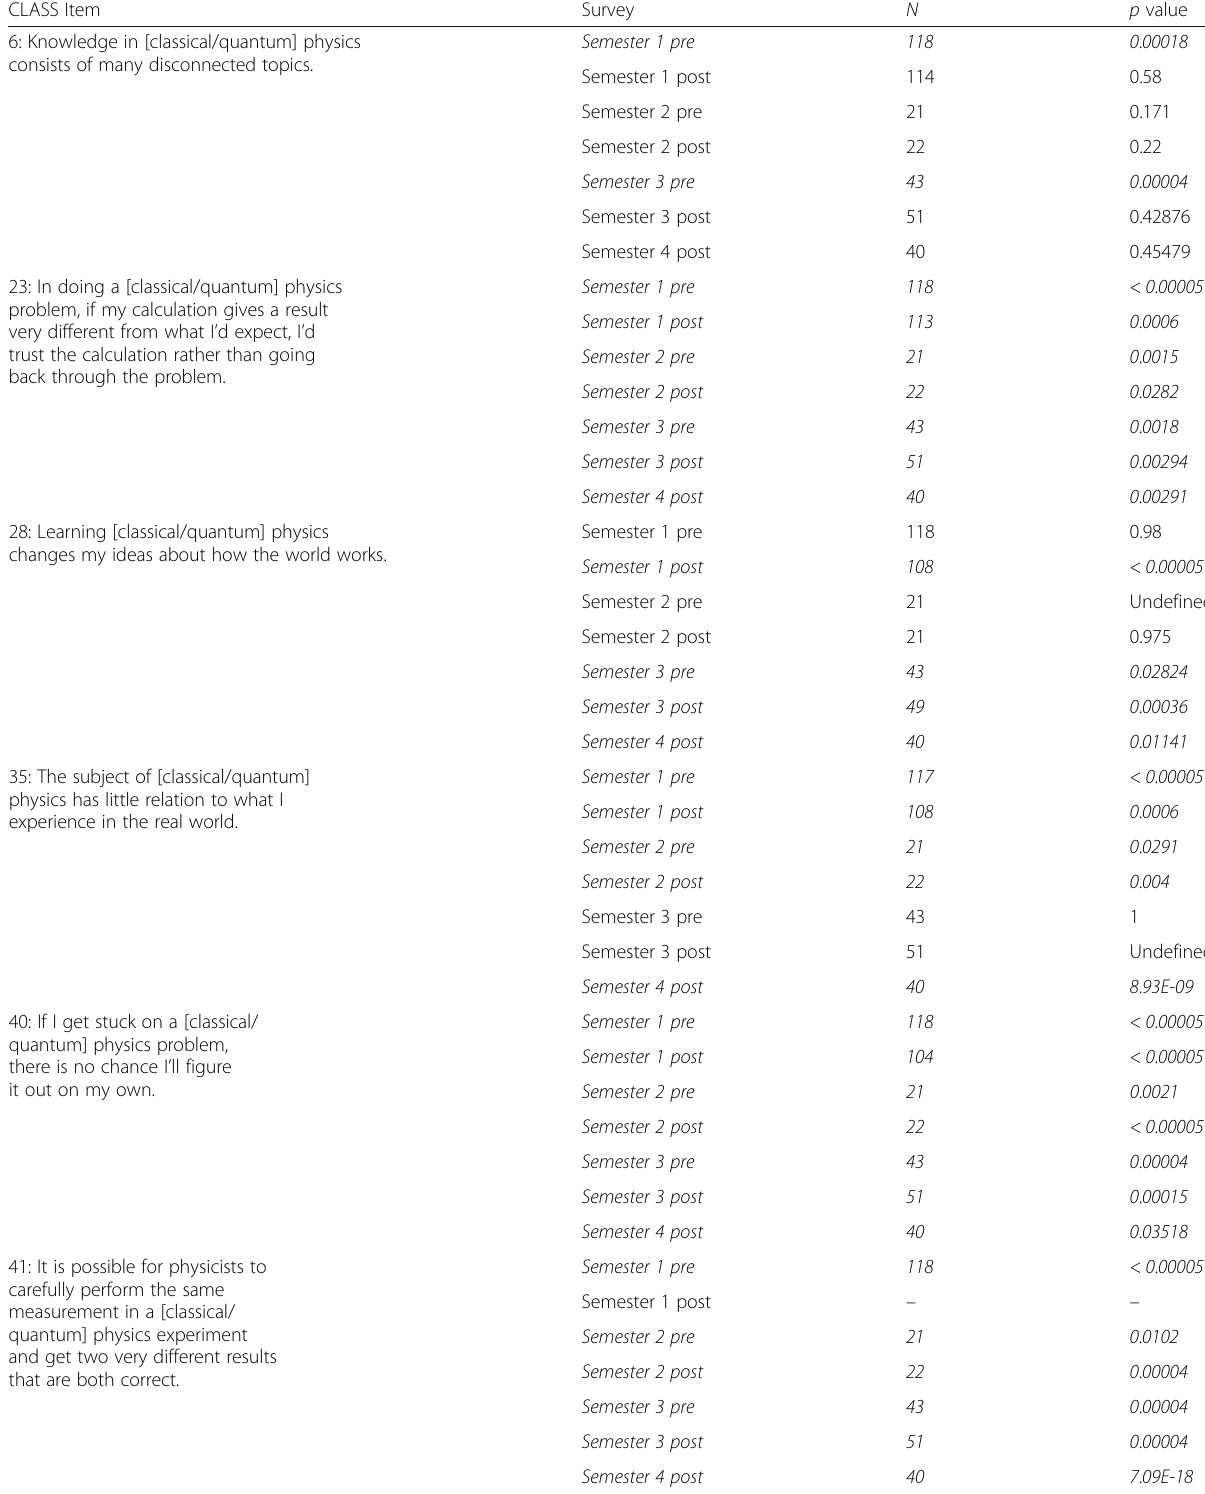
Table 1 Classical/quantum splits on the bifurcated CLASS questions. The p values are determined with the Bhapkar test and corrected using the Holm-Bonferroni method. Items with significant splits at the α = 0.05 level are indicated in italic CLASS